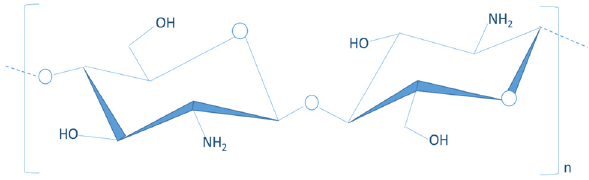
Figure 1: Chemical structure of